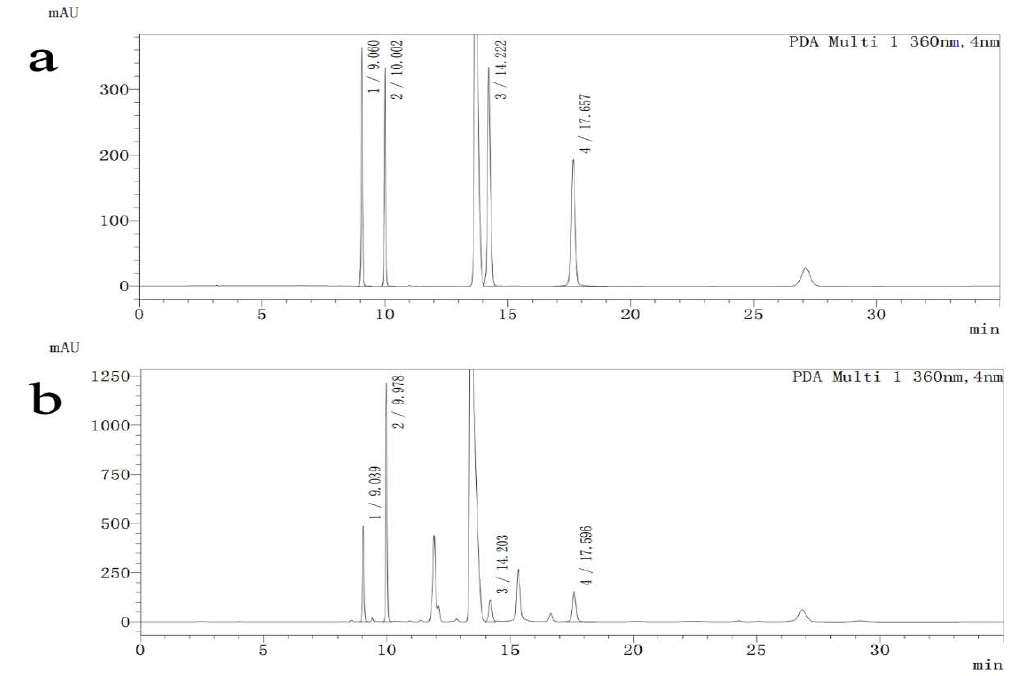
Figure 6. HPLC separation chromatograms for standard solutions and samples. (1) Asp, (2) Glu, (3) Gly, (4) γ-GABA. ( a ) Standard solutions, ( b ) Samples.